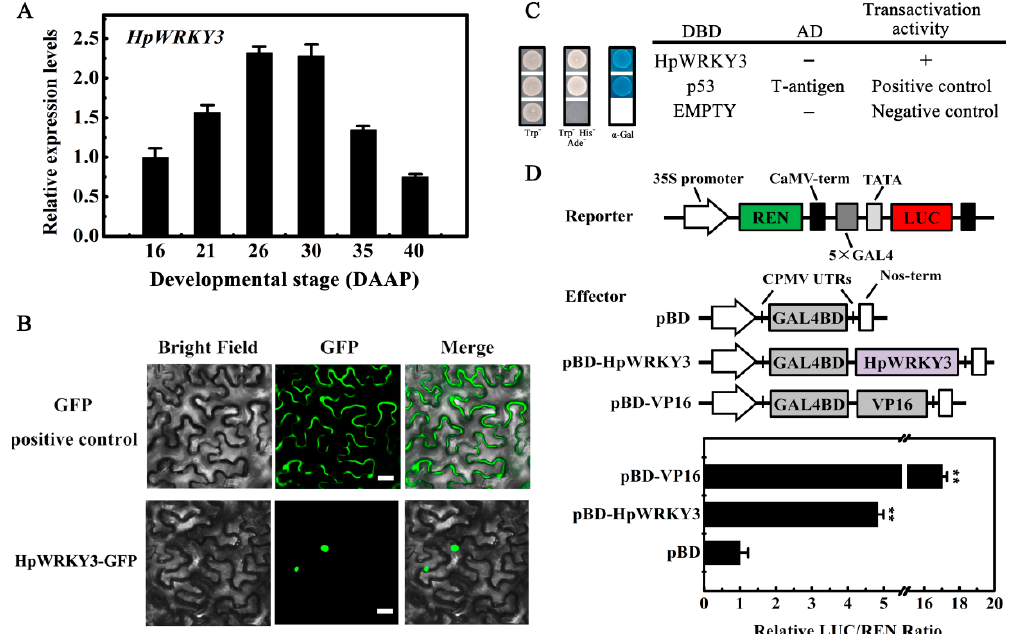
Figure 5. Molecular properties of HpWRKY3. ( A ) Temporal expression patterns of HpWRKY3 during pitaya fruit maturation. Fruit at 16, 21, 26, 30, 35, and 40 days after artificial pollination (DAAP) was sampled for analysis. Expression values are means ± S.E. of three biological replicates normalized using ACTIN as an internal control. ( B ) Subcellular localization of HpWRKY3 in epidermal cells of tobacco leaves. A plasmid harboring GFP or HpWRKY3-GFP was transformed into Nicotiana benthamiana leaves by Agrobacterium tumefaciens strain EHA105. GFP signals was observed with a